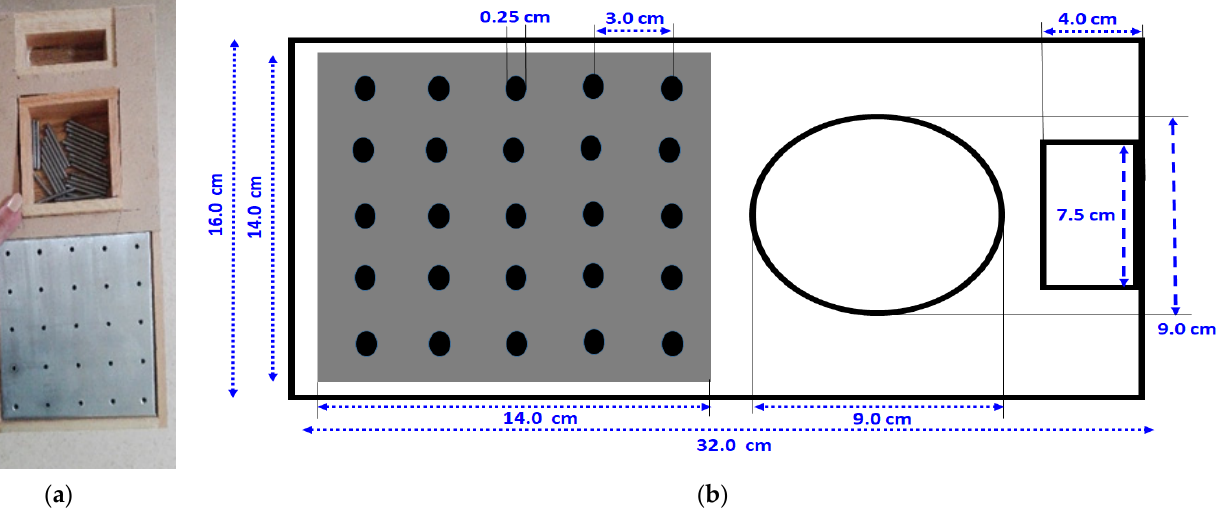
Figure 2. The image ( a ) is the external look of the proposed pegboard and its geometrical dimensions ( b